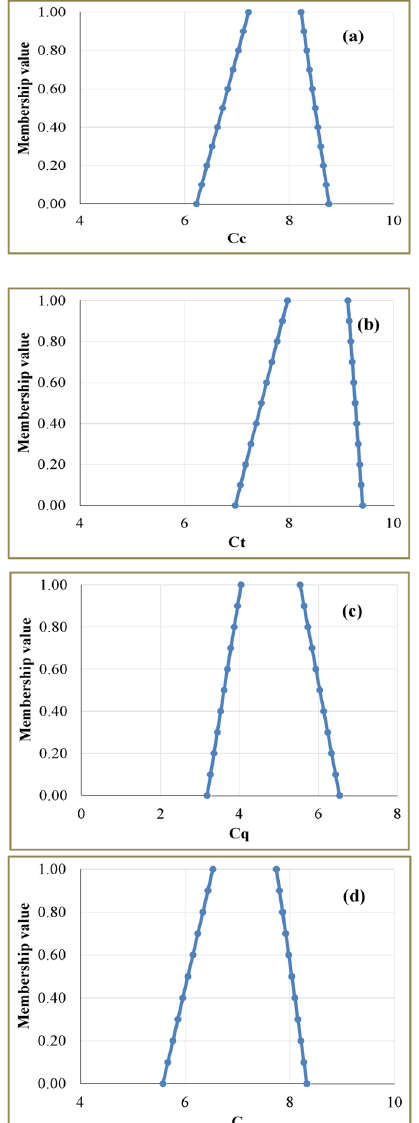
Fig. 5. Fuzzy numbers of the consequence for the risk event of “Increase in tar price” with respect to (a) cost; (b) time; (c) quality and (d) combination of the three criteria